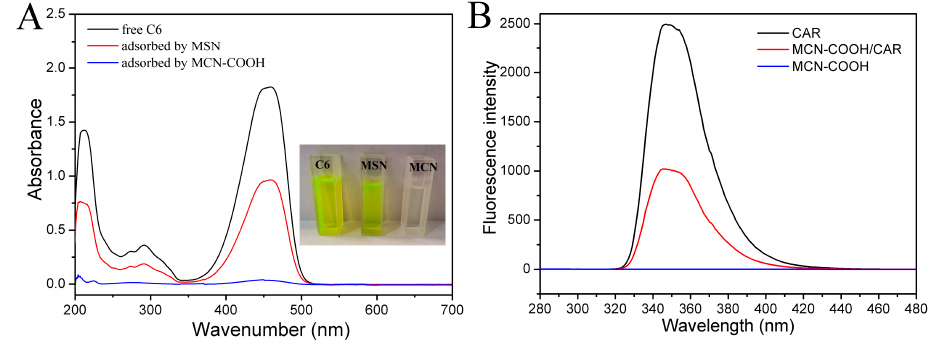
Figure 4. ( A ) Photograph of the supernatant after MCN–COOH and MSN adsorption and